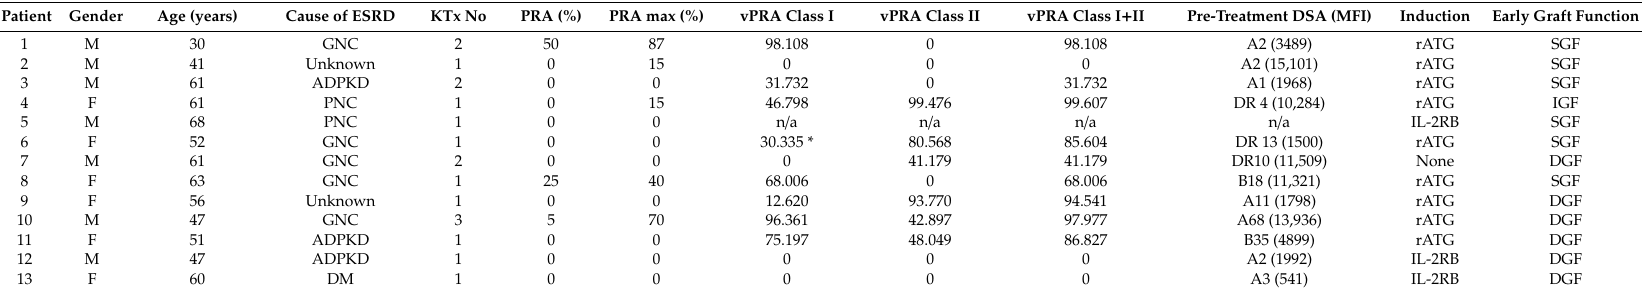
Table 1. Baseline demographic and clinical characteristics of kidney transplant recipients with bortezomib-treated antibody-mediated rejection (AMR). Patient Gender